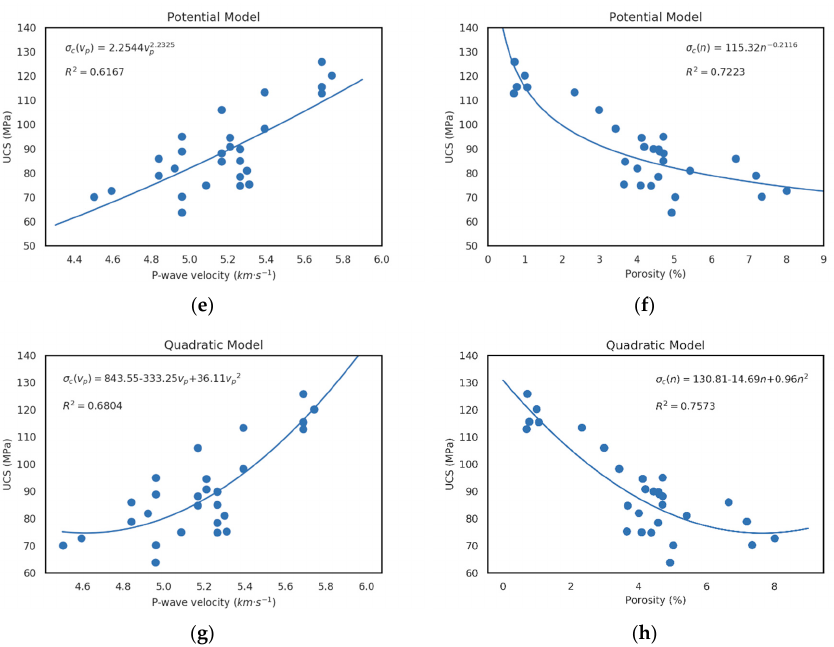
Figure 4. Relationship between UCS and independent variables: P-wave velocity and porosity for analytical models ( a , b ) linear, ( c , d ) exponential, ( e , f ) potential and ( g , h ) quadratic.